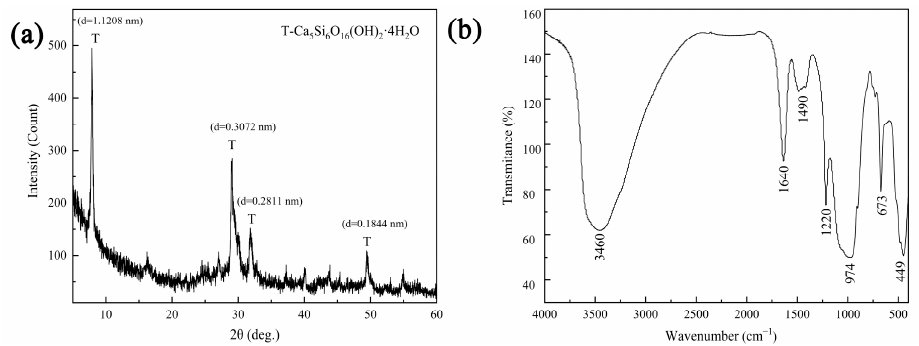
Figure 1. XRD pattern ( a ) and FTIR spectrum ( b ) of tobermorite.